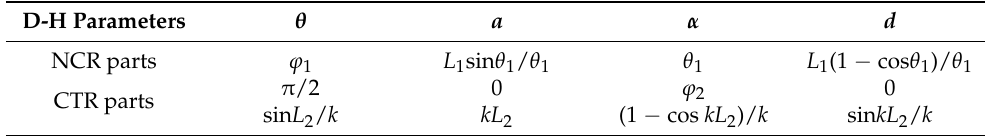
Table 1. CCR’s D-H